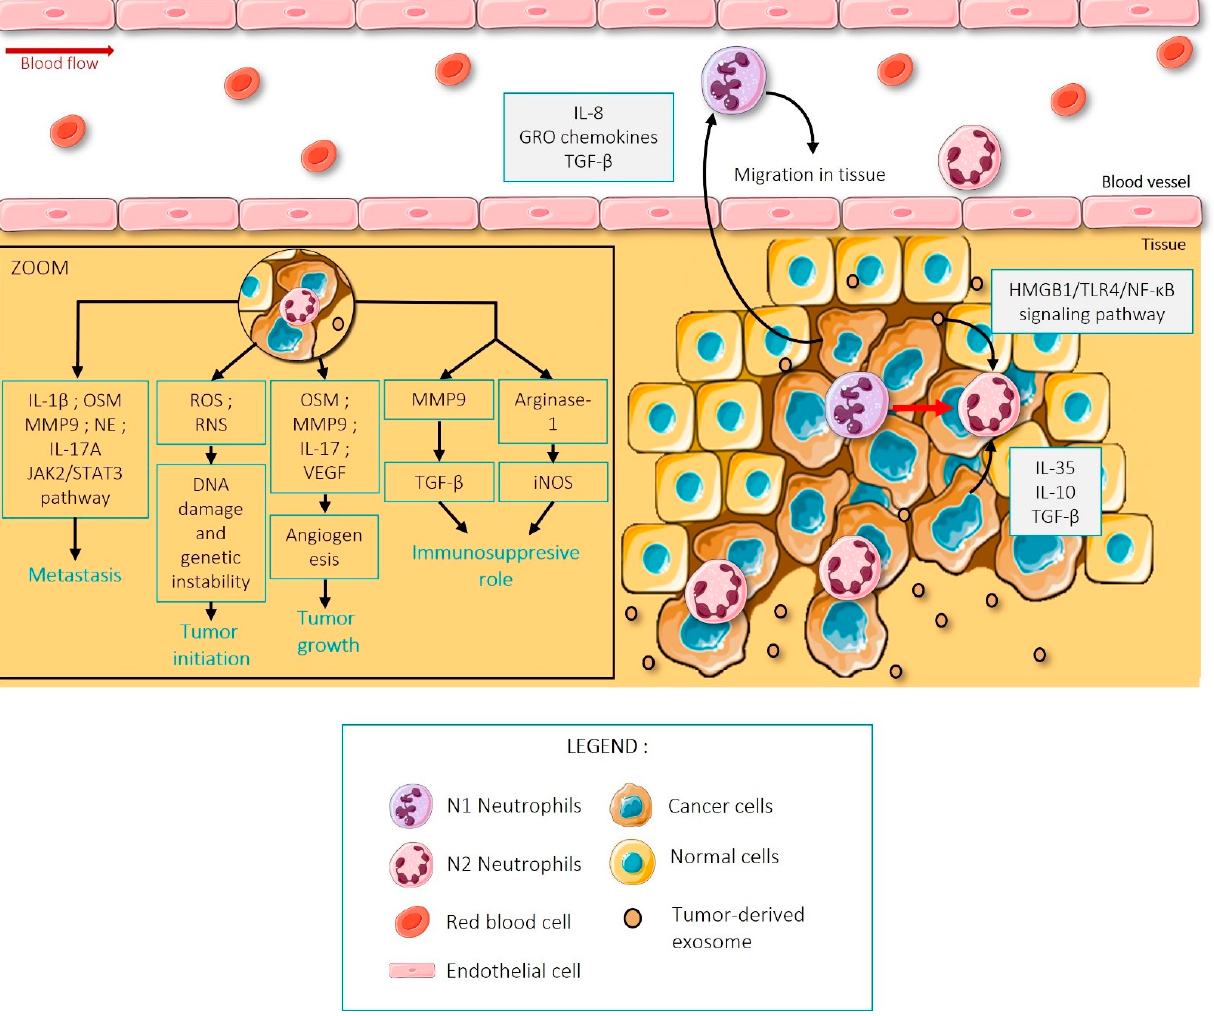
Figure 3. Summary of the role of N2 neutrophils during tumor development. Tumor cells can recruit circulating neutrophils and induce a switch from N1 to N2 neutrophils. Indeed, N2 neutrophils play an important role in several stages of cancer development, like tumor initiation and growth or metastasis formation by secreting several key molecules. Figure created using Servier Medical Art available at http://smart.servier.com/ (accessed on 15 September 2021).